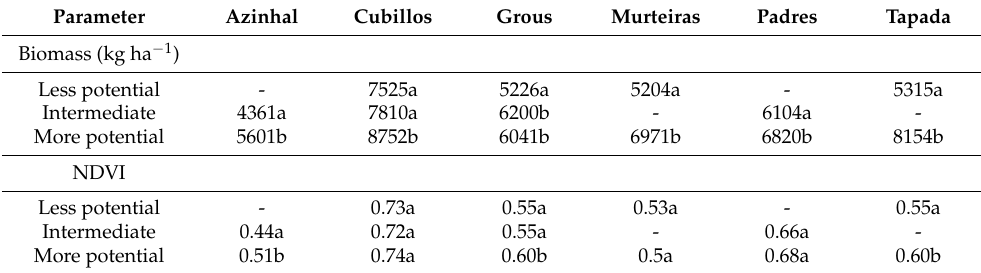
Table 7. Mean values of the pasture parameters in each management zone (less, intermediate and more potential) within each experimental field. Different letters indicate significant differences ( p < 0.05) according to the Dunn test.